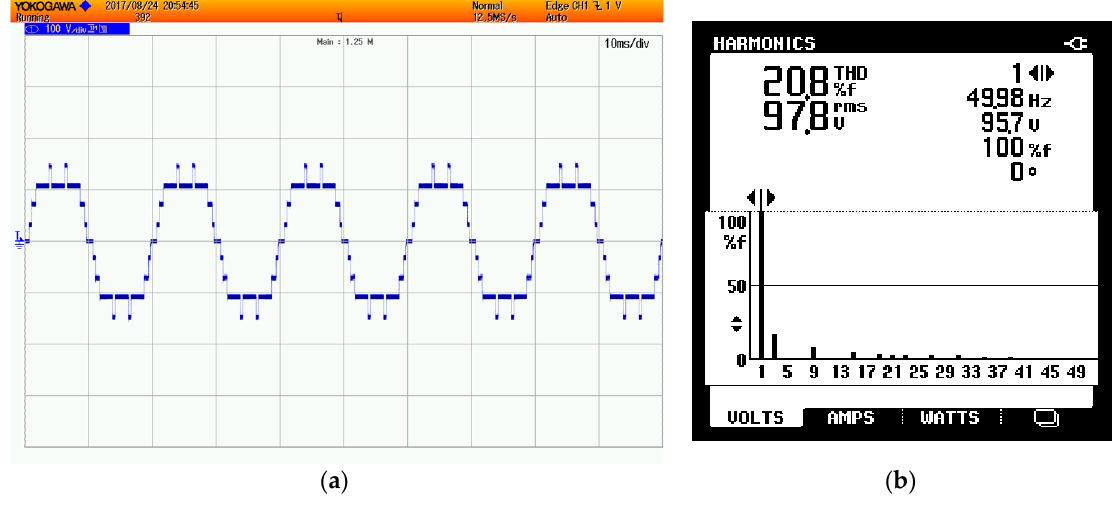
Figure 12. Experimental results of output voltage and THD of pattern of Figure 3b in ( a , b ) respectively.